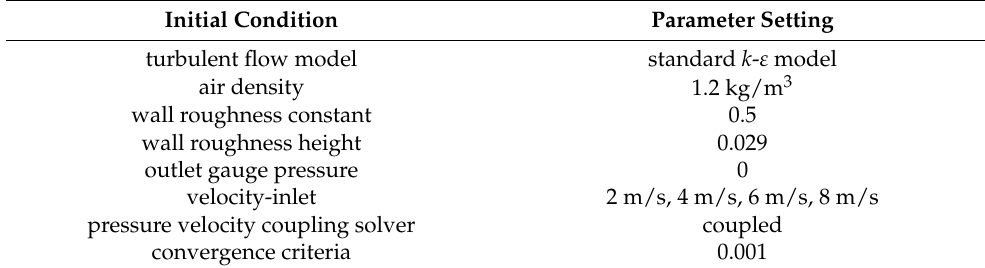
Table 10. Initial conditions of three-dimensional roadway